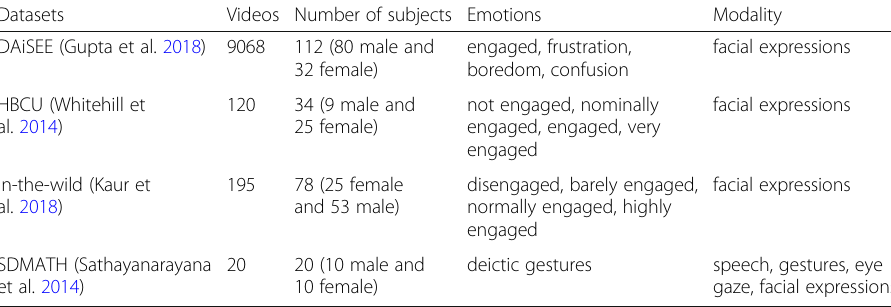
Table 2 Datasets for learners ’ engagement detection